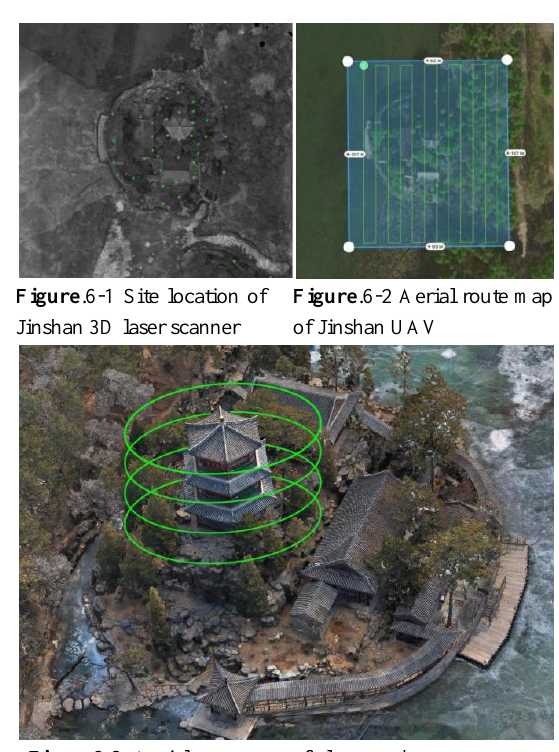
Figure6-3 . Aerial route map of close to photogrammetry with UAV (From Xie